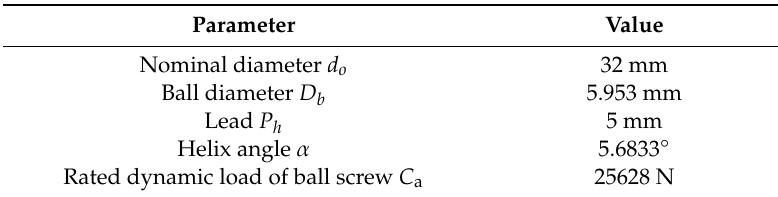
Table 1. Parameters of the ball screw.